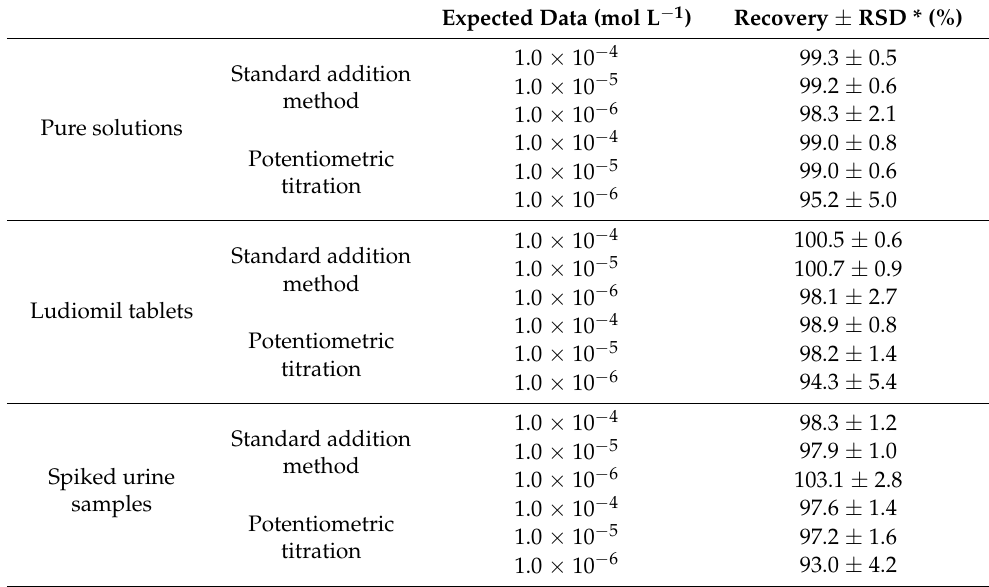
Table 4. Analysis of MAP in pure solution, drug tablets, and spiked urine